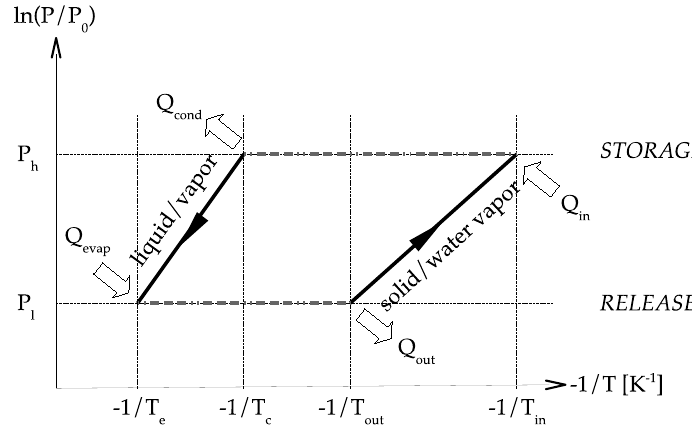
Figure 3. Theoretical Clausius–Clapeyron chemical sorption cycle – reproduced from [1], copyright permission: Elsevier, 2019.